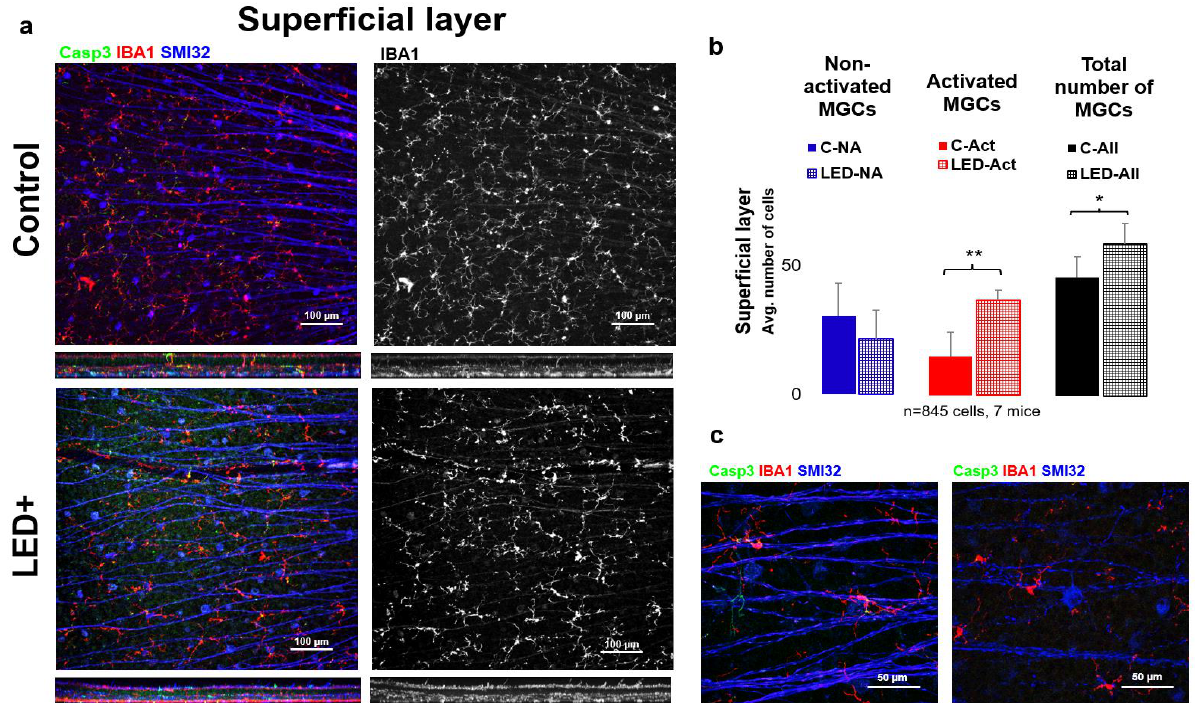
Figure 2. Microglia activation in the superficial layer (inner retina GCL). Panel ( a ) shows the ganglion cell layer of control and LED retinas labeled SMI32 (GC marker), Iba1 (MG marker), and Casp3 (Casp3+ cells). The colors shown are the same as the colors above the images. In the second column, only Iba1-labeled microglia are shown in white. In panel ( b ) the histogram shows the number of non-activated, activated, and total microglia counted in the SL (* p = 0.05; ** p = 0.01). ( c ) Shows high-magnification confocal microscopic images scanned with a 63 × objective of activated MGs (left) and non-activated MGs